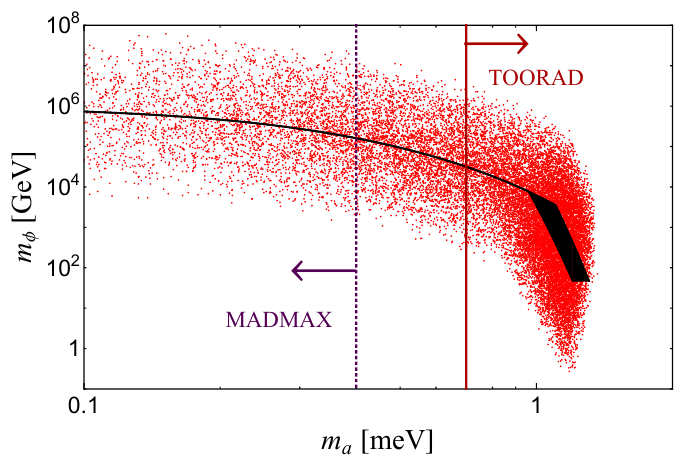
Figure 4 . The relation between the QCD axion mass m a and the in(cid:13)aton ( (cid:25) n(cid:13)aton) mass m (cid:30)